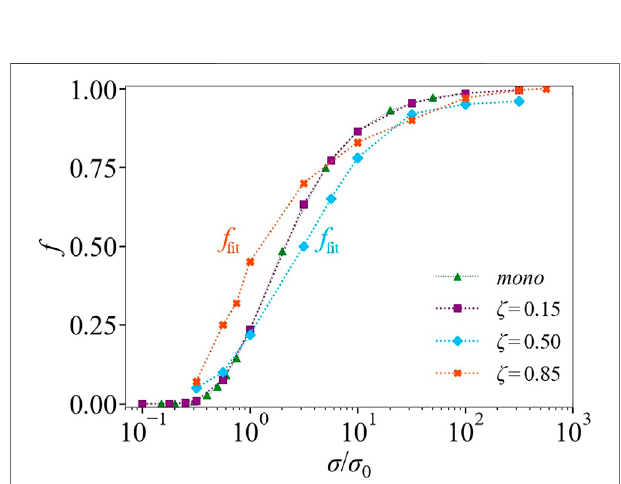
FIGURE 7 | Fraction of frictional contacts f and f fi t as a function of dimensionlessshearstress σ / σ 0 formonodispersesuspension δ =1.4 ζ =0.50 and bidisperse suspensions δ =3 for ζ = 0.15, 0.50 0.85. For δ = 1.4 with ζ = 0.50 and δ = 3 with ζ = 0.15, the form of f is exponential f ( σ ) = exp ( σ */ σ ) with σ * = 1.45. For ζ = 0.50 and 0.85, it is fi tted manually f = f fi t .